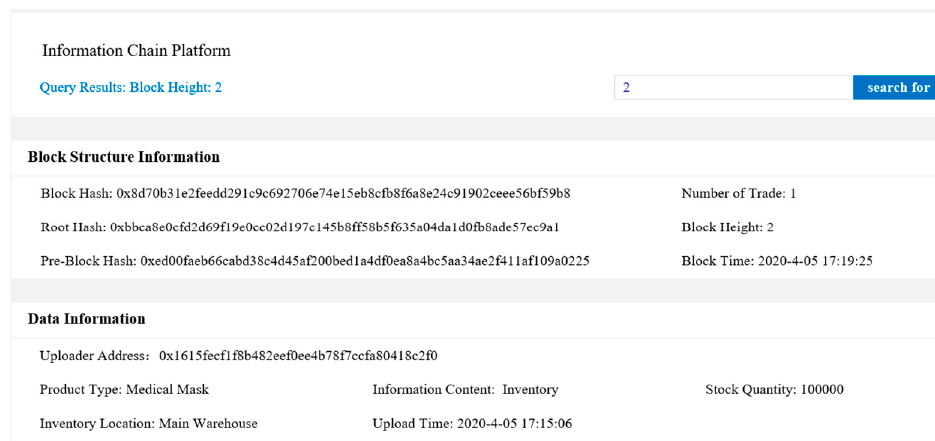
Figure 11. Product information block.